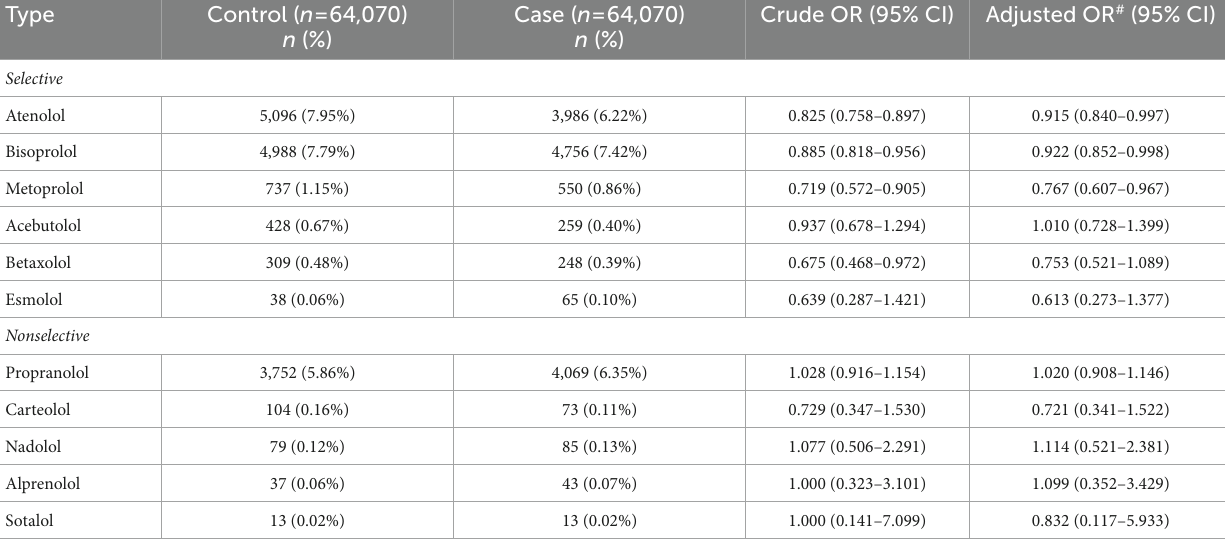
TABLE 3 The association between the use of selective and nonselective beta-blockers and the risk of